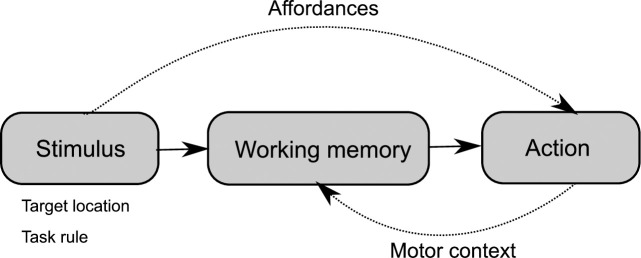
Hypothetical (model) framework illustrating how the maintenance of mnemonic material could be modulated by future motor context.Mnemonic stimulus material (e.g. visual target location, as in our experiment) and task rules afford the motor context in which this material is likely to be used. Predicted motor context information is fed back to WM processes to enable optimal storage for guiding future action.